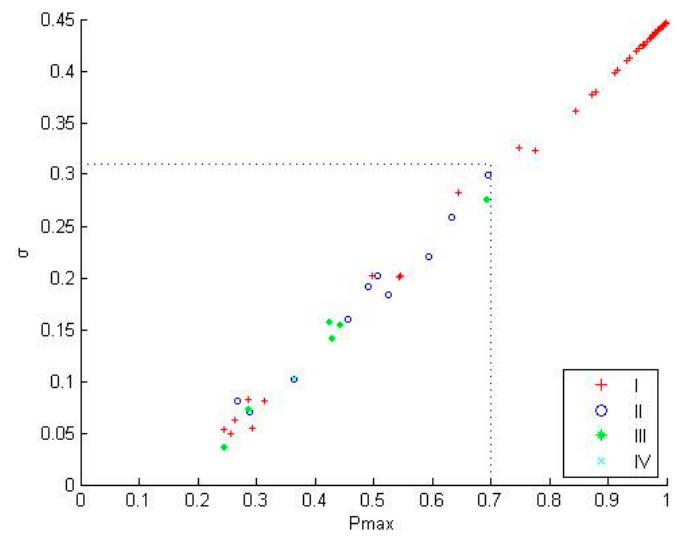
Figure 6. Scatter diagram of the classification.